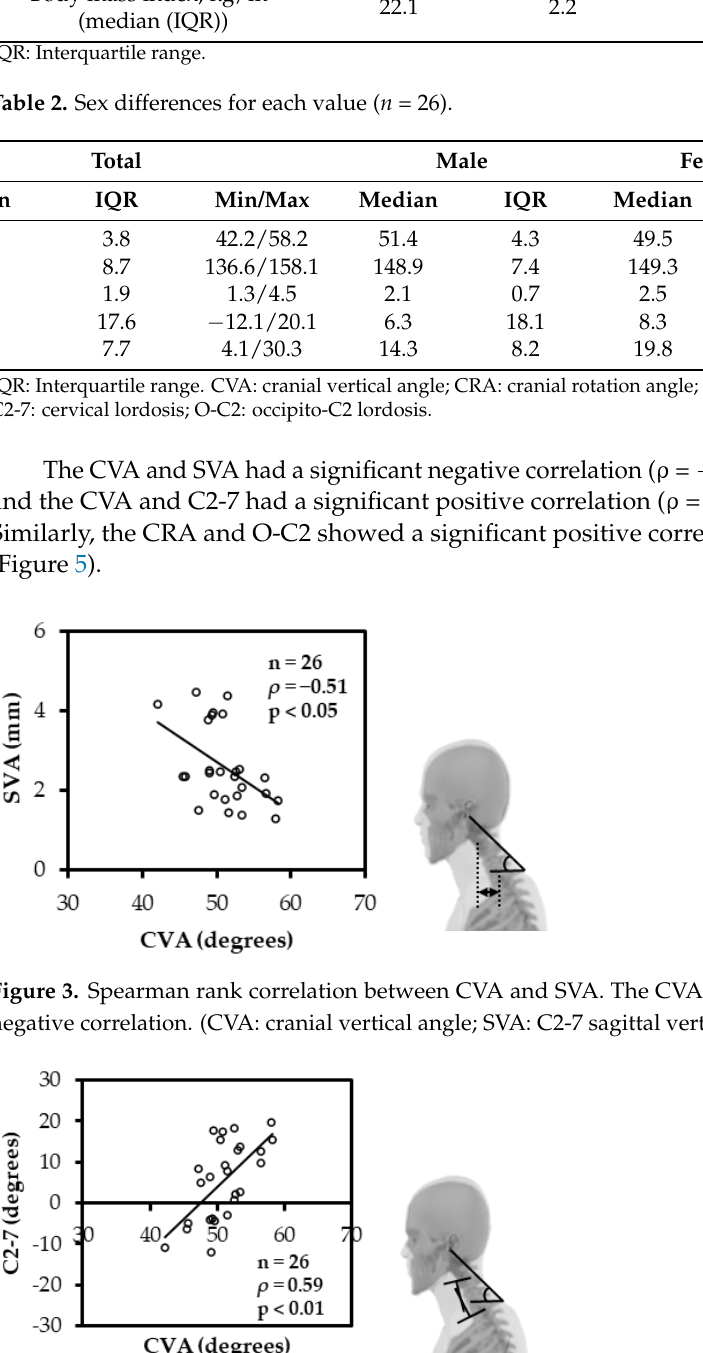
Figure 5. Spearman rank correlation between CRA and O-C2. The CRA and O-C2 showed a signif- icant positive correlation. (CRA: cranial rotation angle; O-C2: occipito-C2 lordosis). Table 3 shows the results of correlations between demographic data and CVA or CRA. There was a correlation between CVA and age (Table 3). Multiple regression analy- sis with CVA as the dependent variable showed a significant partial relation with C2-7 and SVA and no significant relation with age (Table 4). A simple regression analysis with CRA as the dependent variable showed a significant partial relation with O-C2 (Table 5). Table 3. Spearman rank correlation between CVA, CRA, and demographic data ( n = 26). Age